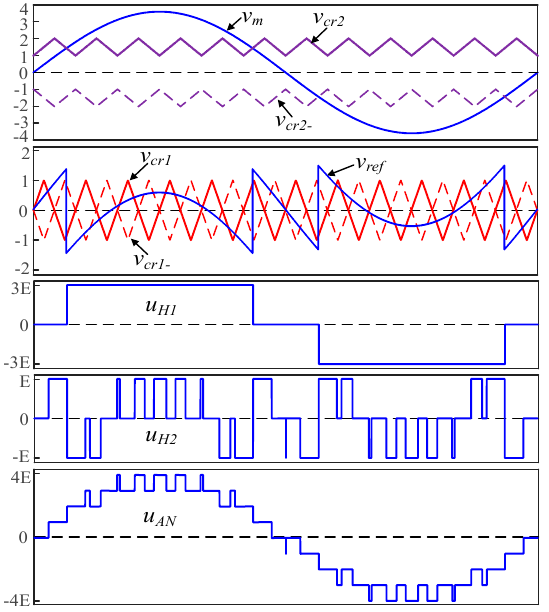
Figure 4. The principle diagram of modified hybrid frequency modulation (MHF-PWM).